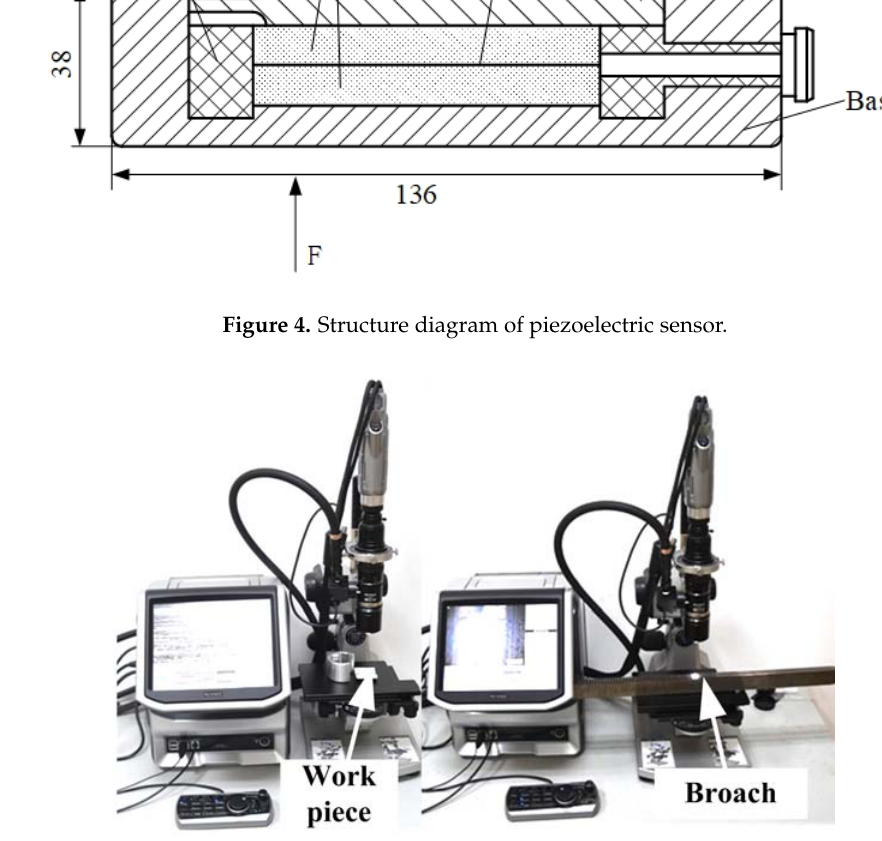
Figure 5. Work piece surface and broach wear observed.